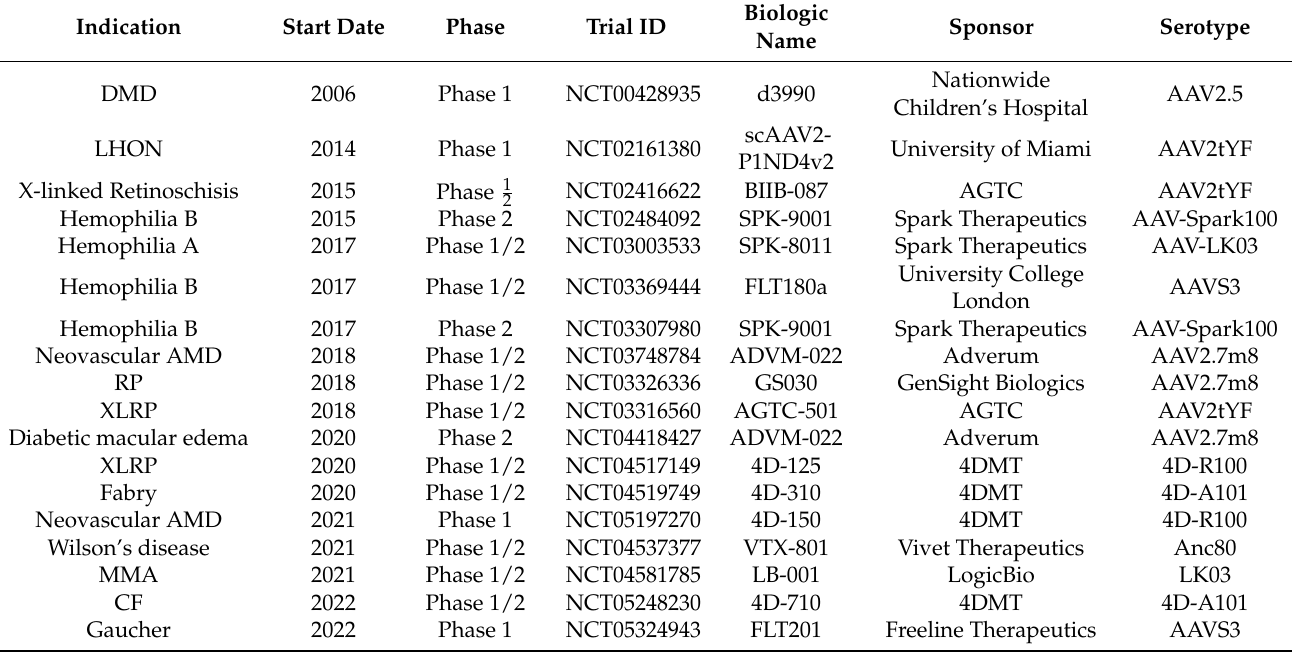
Table 3. Clinical trials using engineered AAV